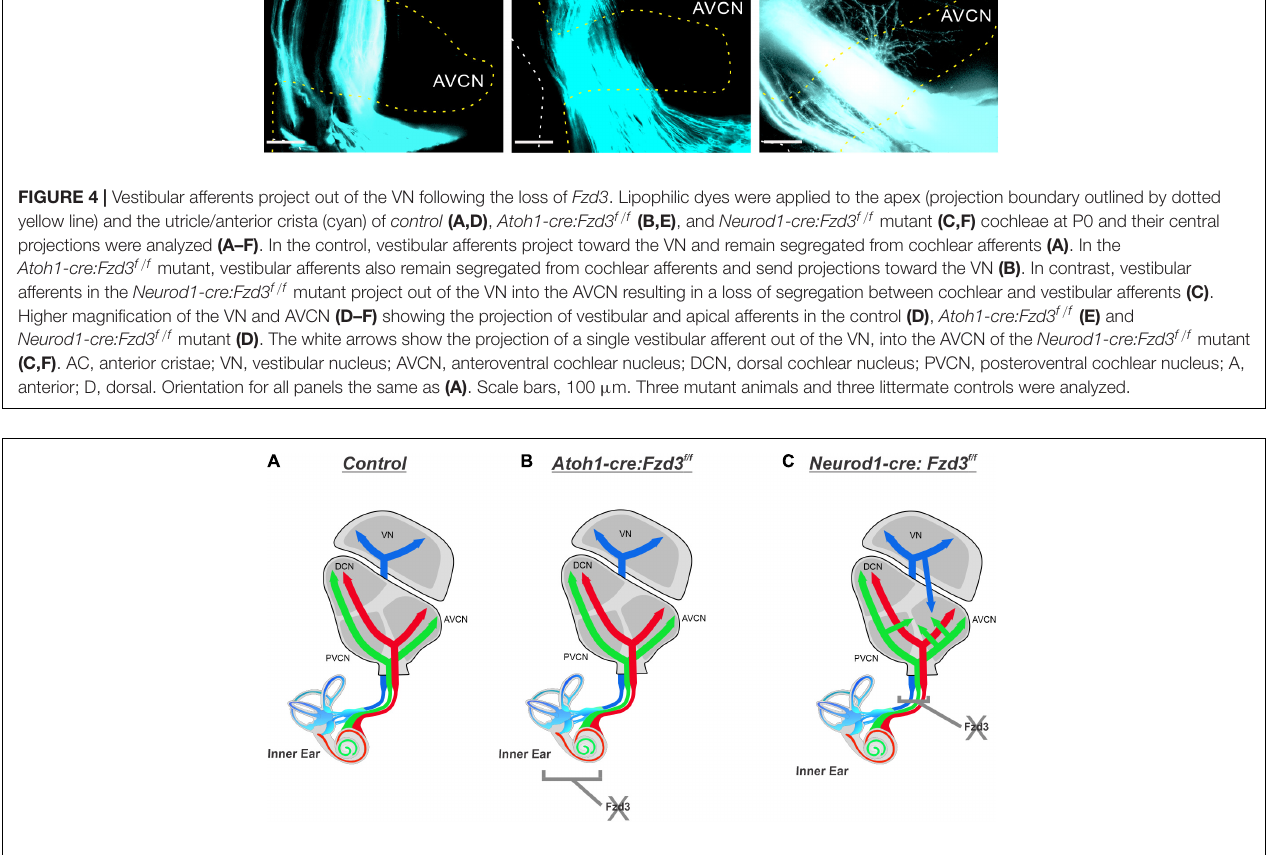
FIGURE 5 | Proposed effect of Fzd3 in inner ear afferent central pathfinding. Cochlear afferents from the base (red) and apex (green) project into the CN and bifurcate sending projections toward the DCN and AVCN while maintaining the tonotopic map established in the periphery (A) . Vestibular afferents (blue) project toward the VN and remain segregated from cochlear afferents (A) . Inner ear afferent central pathfinding is unaffected by loss of Fzd3 within the hair cells in Atoh1-cre:Fzd3 f / f mutants (B) . Loss of Fzd3 within inner ear afferents in Neurod1-cre:Fzd3 f / f mutants disrupts central pathfinding, resulting in aberrant projection of both apical SGNs and vestibular afferents (C) . VN, vestibular nucleus; CN, cochlear nucleus; AVCN, anteroventral cochlear nucleus; DCN, dorsal cochlear nucleus; PVCN, posteroventral cochlear